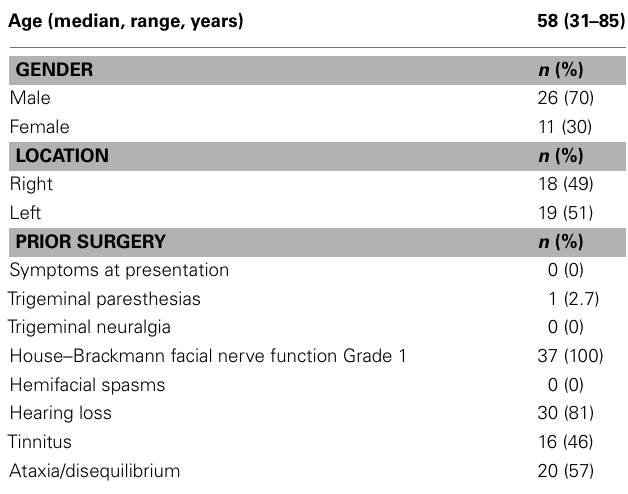
Table 1 | Patient characteristics.